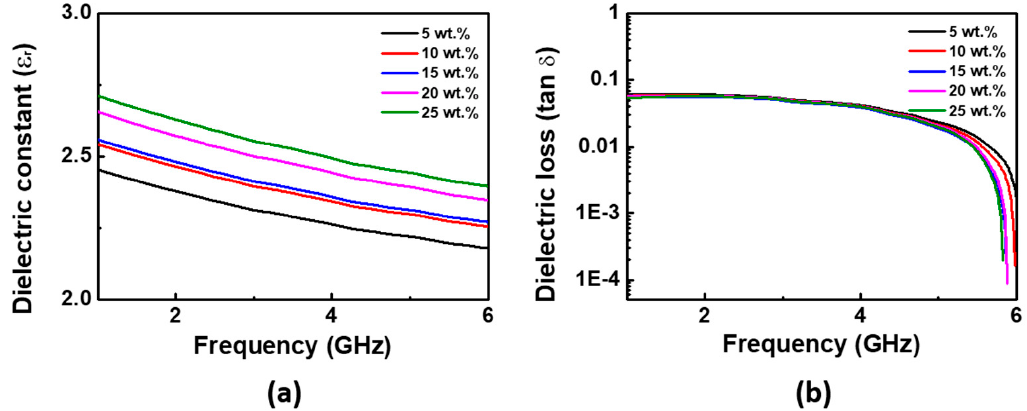
Figure 6. ( a ) Dielectric constant and ( b ) dielectric loss of the 3D-printed thin film with the PCL/HA composite filaments.